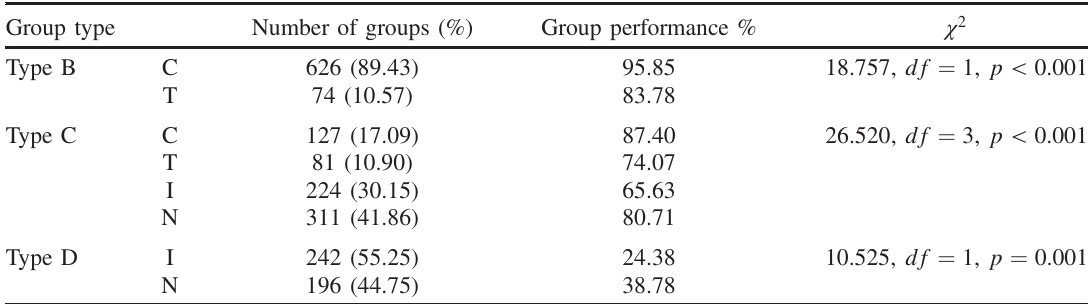
TABLE IV. Group performance according to the majority of individual-round answers in the group. α is 0.05. Group